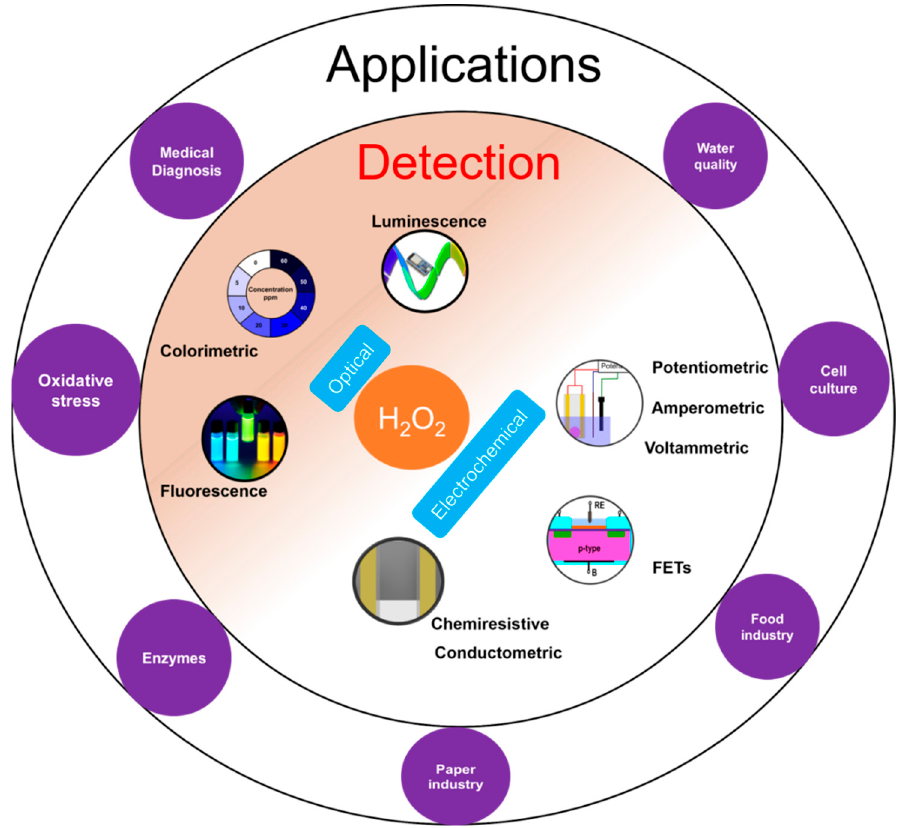
Figure 1. Overview of H 2 O 2 detection with inner circle containing the two common detection prin- ciples: optical and electrochemical; and outer circle with few applications areas of H 2 O 2 detection.